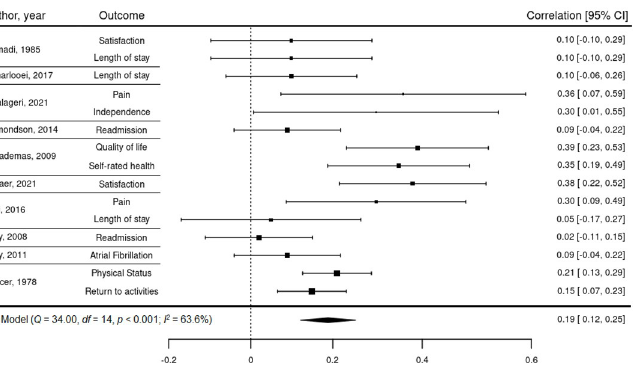
Fig 2. In-hospital stress on patient outcomes: A forest plot of correlation coefficients within the included studies.